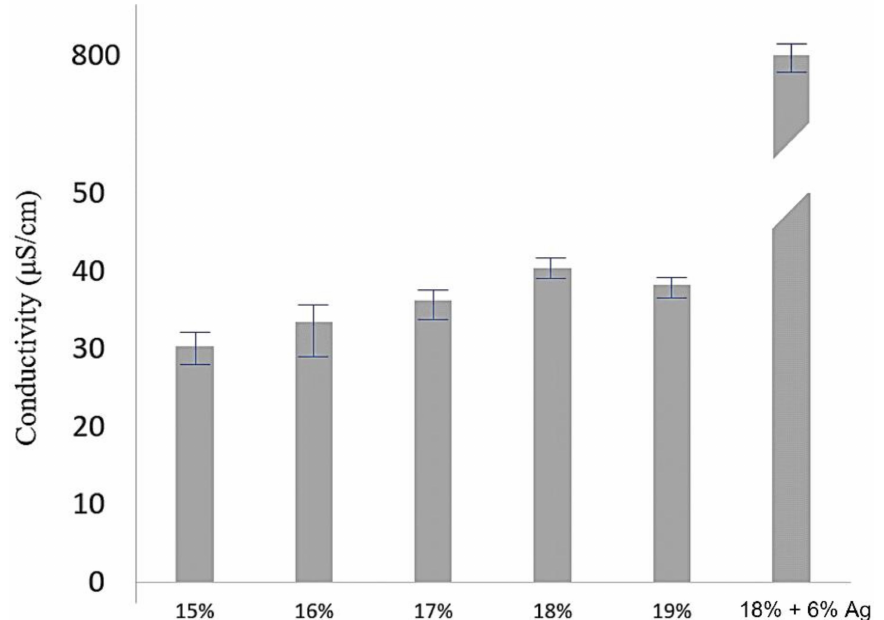
Figure 6. Electrical conductivity of single PVDF electrospinning solutions (15wt%~19wt%) and PVDF electrospinning solution with 6% AgNO 3